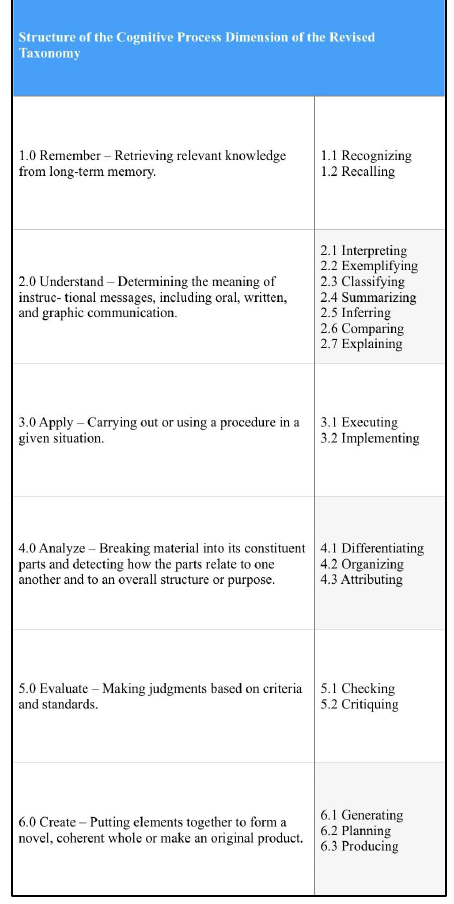
Figure 9. Subcategories of the Cognitive